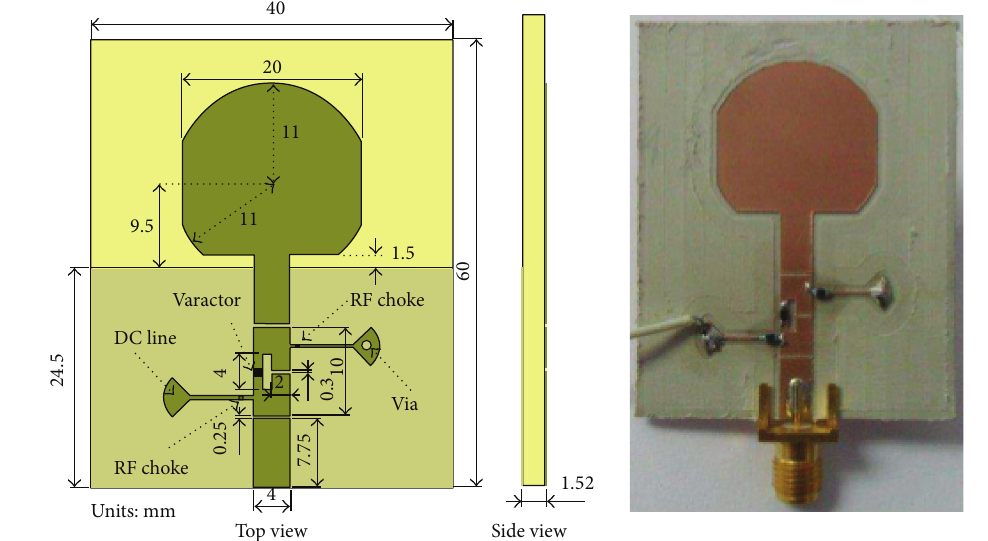
Figure 10: Geometry and photo of a tunable narrowband filtenna.